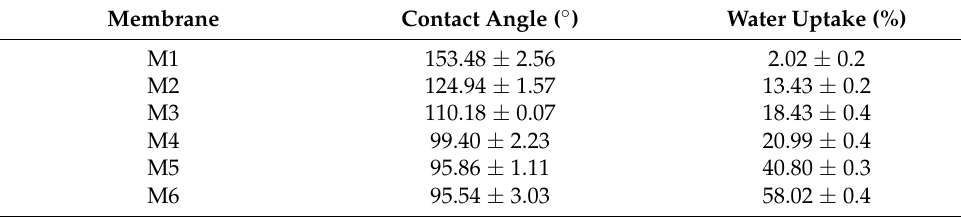
Figure 11. AFM image of M1, M2, M3, M4, M5 and M6. Table 6. Contact angle, thickness and water uptake of